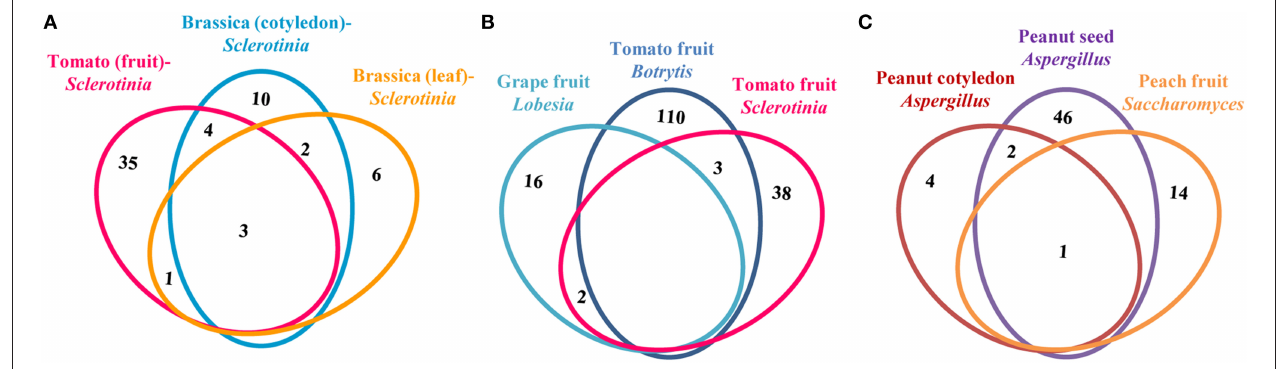
FIGURE 8 | Comparative analyses of patho-stress proteomes. Venn diagram showing overlapping proteins during (A) Sclerotinia interaction with host storage organs, (B) Compatible interaction of necrotrophs with host storage organs, and (C) Incompatible interaction of necrotrophic fungi with host storage organs. The numbers signify the unique and/or orthologous proteins among the organisms studied. The areas are not proportional to the number of proteins in the